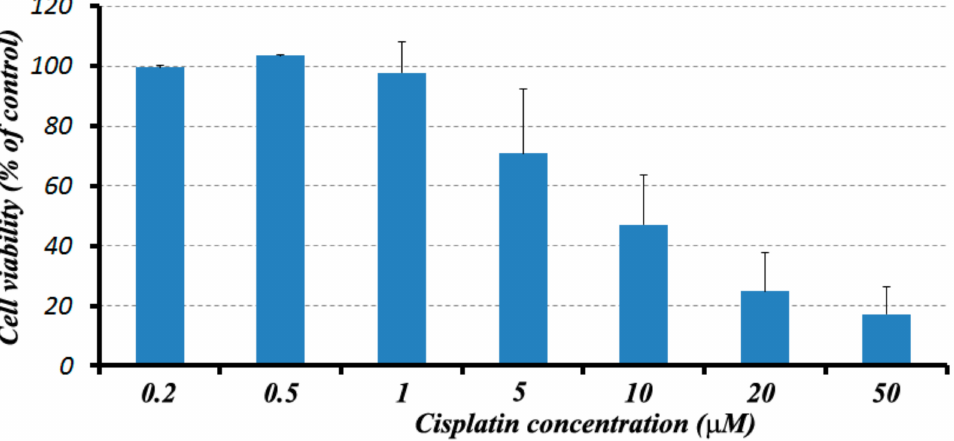
Figure A4. Cell viability of U87 in the presence of increasing concentrations of Cisplatin. Values were obtained as bioluminescent signal expressed as radiance in photons per second per square centimeter per steradian (p/s/cm 2 /sr) and expressed as percentage of control cells (treated in complete medium, in the absence of